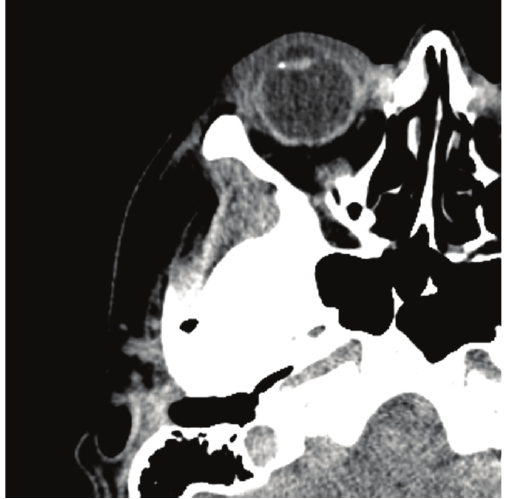
Figure 3: An anterior segment OCT demonstrating scleral flap covered by